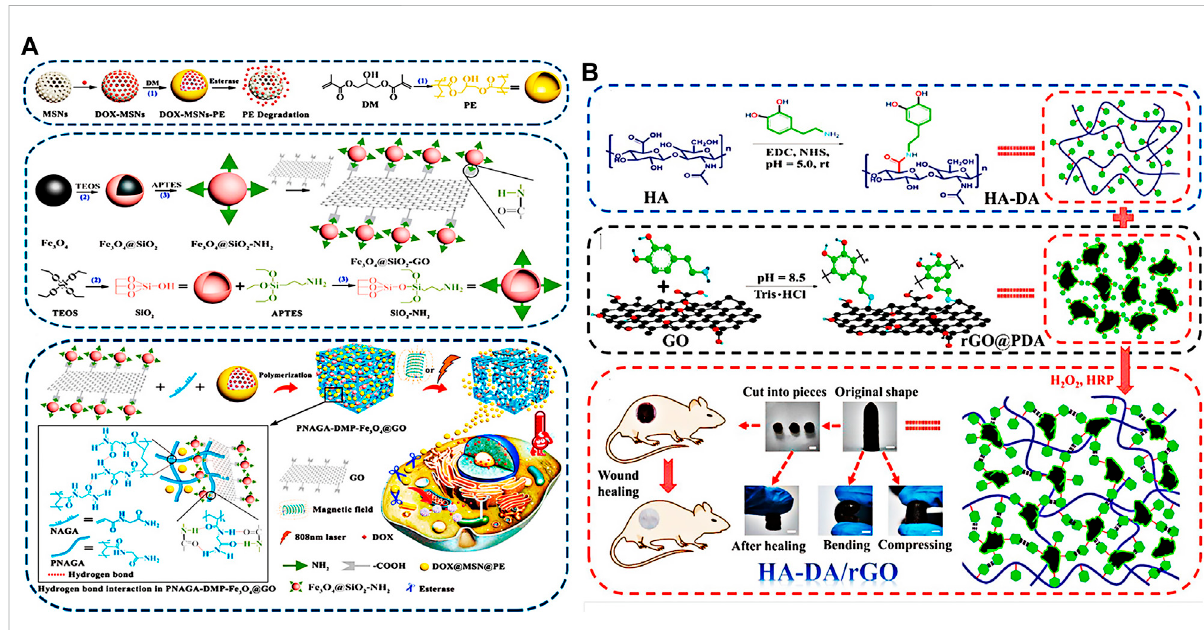
FIGURE 2 (A) Schematic diagram of the preparation of nanocomposite hydrogel and its mechanism in tumor therapy. Reproduced from ref. 101 with permission from 2020 Elsevier ltd. (B) Diagrammatic sketch of HA-DA/rGO hydrogel preparation. Reproduced from ref. 42 with permission from 2019